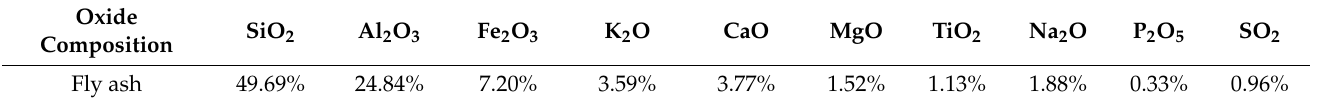
Table 4. Oxide composition of fly ash.